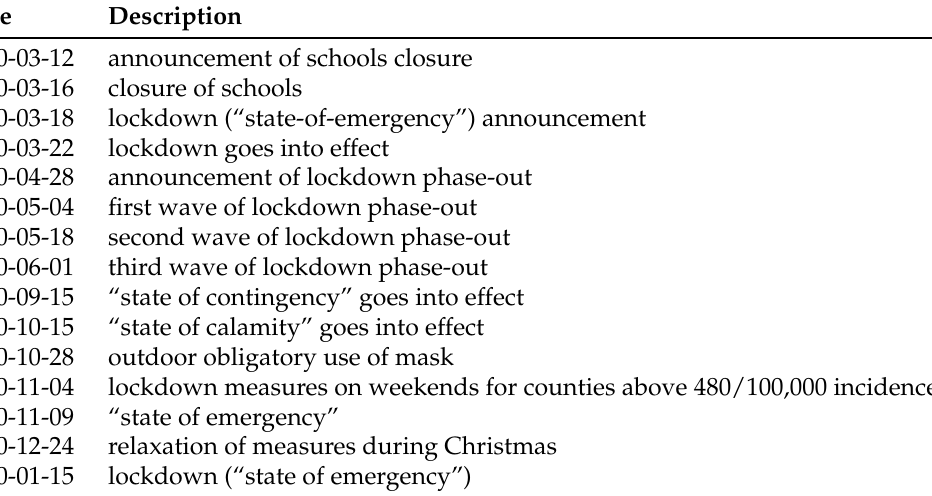
Table A2. Introduction and lifting of NPI adopted in Portugal, dates and descriptions.